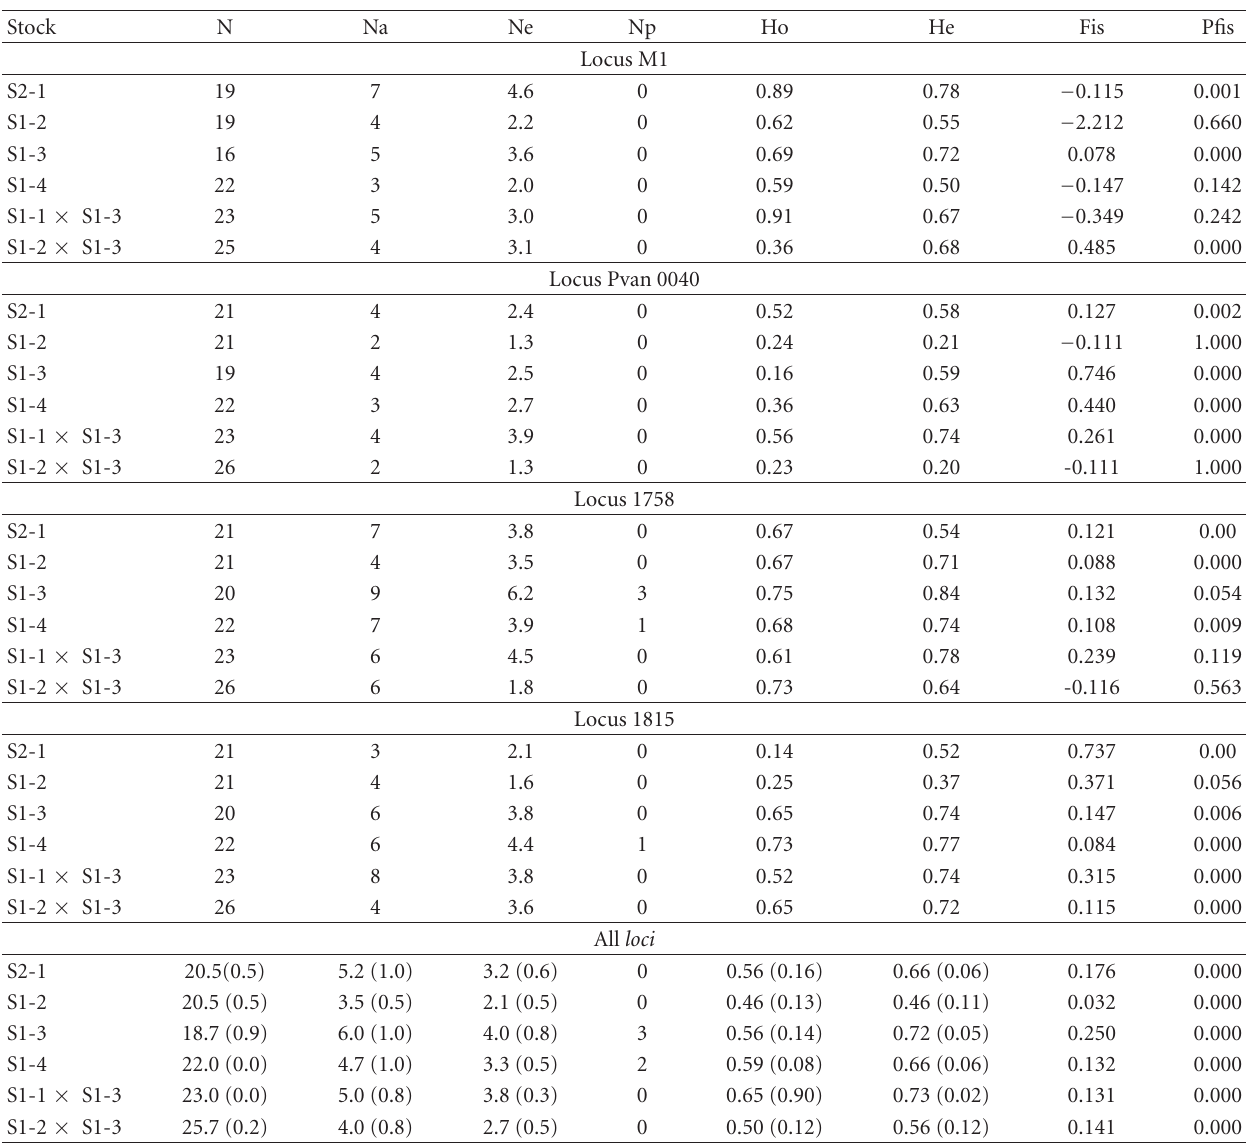
Table 1: Genetic variability parameters and the Hardy-Weinberg deviation of equilibrium ( F IS ) and its probability (Pfis) of four vannamei used for aquaculture in Cuba. n : number of samples. Na: number of alleles, Ne: number of e ff ective alleles, Np: number of private alleles, He: expected heterozygosity, Ho: observed heterozygosity. The associated probability was estimated using the Markov chains (10000 Dememorisation, 100 batches, and 5000 iterations per batch using Genepop program Version 4.1.0. Numbers in parenthesis are standard mean